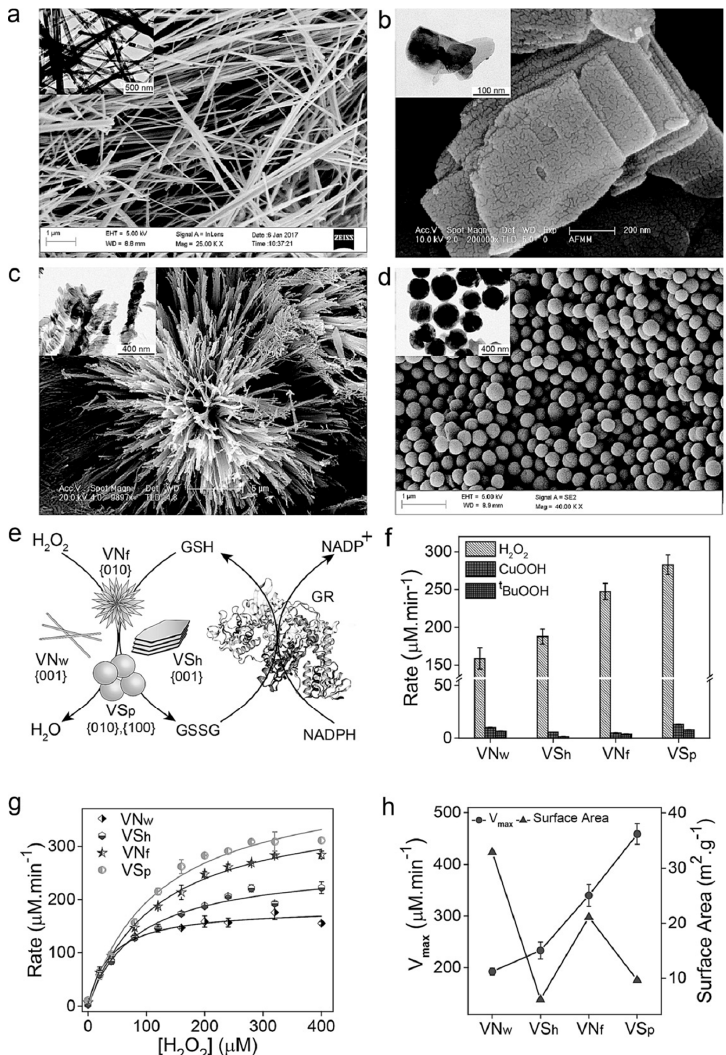
Figure 4. SEM and TEM (inset) images of V 2 O 5 nanowires (V Nw ) ( a ), V 2 O 5 sheets (V Sh ) ( b ), V 2 O 5 nanoflowers (V Nf ) ( c ) and V 2 O 5 spheres (V Sp ) ( d ). Reduction of H 2 O 2 by GSH in the presence of nanomaterials, glutathione reductase (GR) and NADPH ( e ). The GSH peroxidase-like activity using H 2 O 2 , tert-butyl hydroperoxide (t-BuOOH) and cumene hydroperoxide (CuOOH) ( f ). Michaelis–